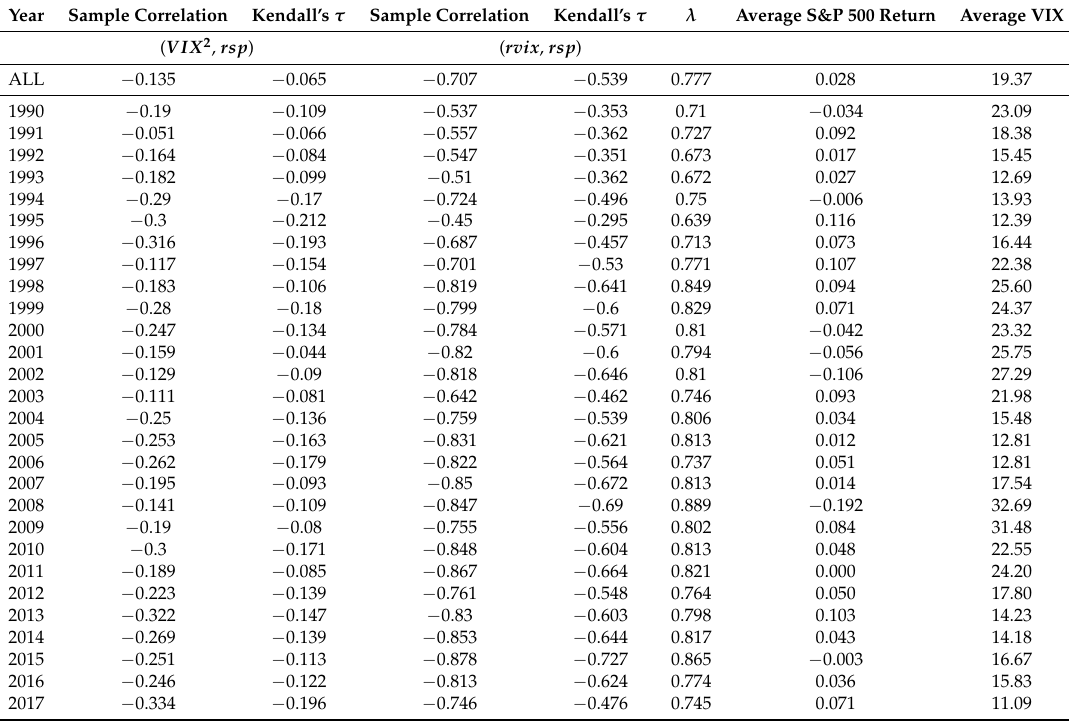
Table 2. Sample Correlation, Kendall’s τ , λ , Average Compound Return of the S&P 500 Index, and Average